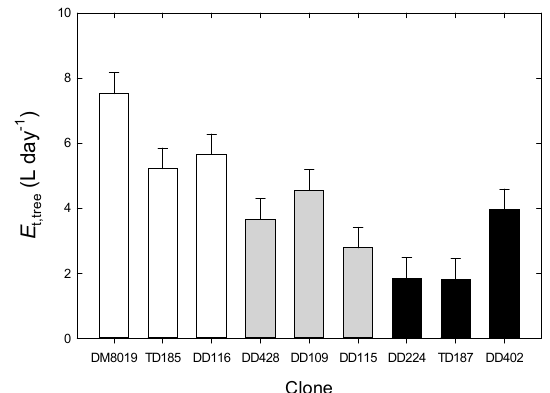
8 of 21 Figure 2. Relationships between ( a ) stem growth efficiency (GE) and ( b ) water use efficiency of production (WUEp) and average relative growth rate (RGR) of biomass growth over the 146 day study period in P. deltoides (DD), P. trichocarpa x deltoides (TD), and P. deltoides x maximowiczii (DM) clones. Open, light shaded, and dark shade symbols represent high (Group H), intermediate (Group I), and low (Group L) productivity genotypes, respectively. In panel a, the grey line is the regression for DM and DD clones and the black is for TD clones. 3.3. Tree Water Use and WUEp Daily E t,tree ranged from <1.0 to >20.0 L day − 1 (Figure S1). Averaged over the study period, Group H had significantly greater E t,tree (6.00 ± 0.60 L day − 1 ) than Group I (3.43 ± 0.60 L day − 1 ) or Group L (2.57 ± 0.61 L day − 1 ) ( p < 0.001) (Figure 3). Total E t,tree over the study period was strongly correlated with stem biomass growth (Figure 4a), although there were no significant Group effects on this relationship. Tree WUEp, calculated by dividing stem biomass growth with total E t,tree , increased with RGR (Figure 2b). There were significant clone differences in WUEp ( p = 0.031), however, there were no discernible patterns among